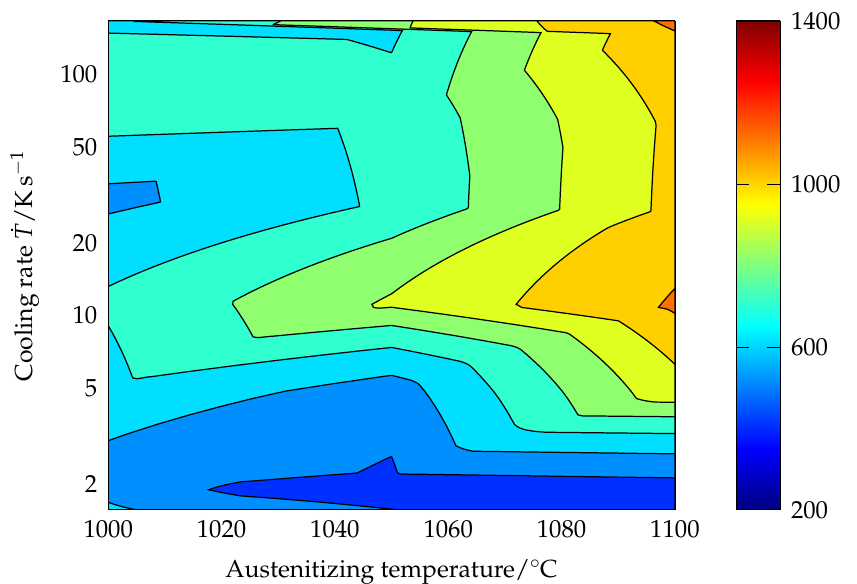
Figure 25. Pitting corrosion potential Ag/AgCl (3 mol KCl) as a function of the cooling rate ˙ T (logarithmic scale) and the austenitizing temperature.